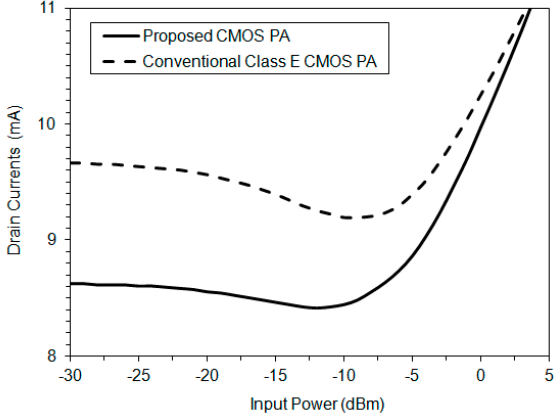
Figure 7. Simulation results of the drain currents versus the input power of the proposed PA IC (solid line) and the conventional PA IC (dotted line).